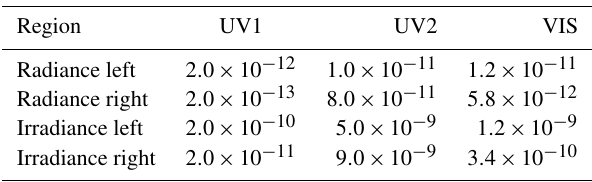
Table 4. Wavelength-averaged degradation over the period 2005– 2017, derived from Sun observations over the three diffusers, for all three channels. In the top three rows the signal fractions in 2017 relative to the first measurement in 2005 are given; the lower three rows list the contributions of the elements in the QVD